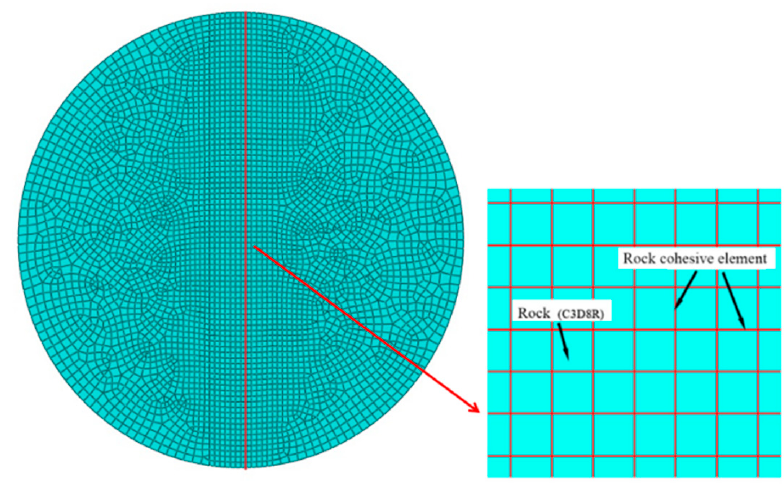
Figure 8. Finite element mesh.